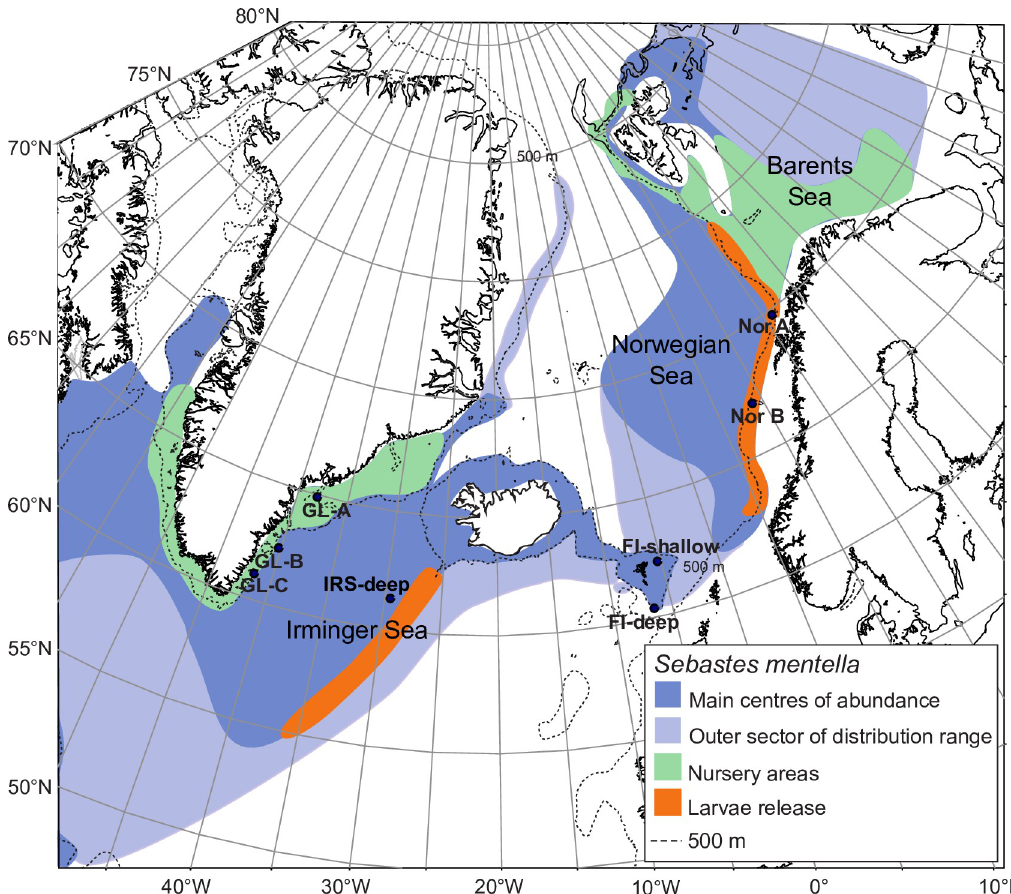
Fig 1. Distribution of S . mentella throughout the Northeast Atlantic (modified from Saha et al . [12]). Sampling locations are indicated by black circles.